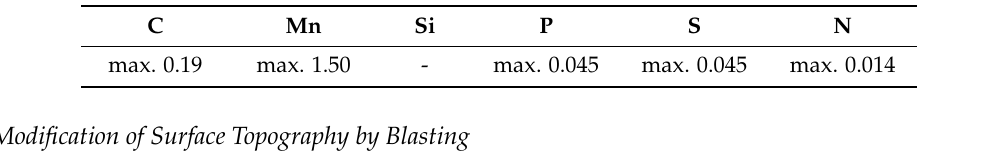
Table 1. Chemical composition of steel S235JRG2 in wt. %.